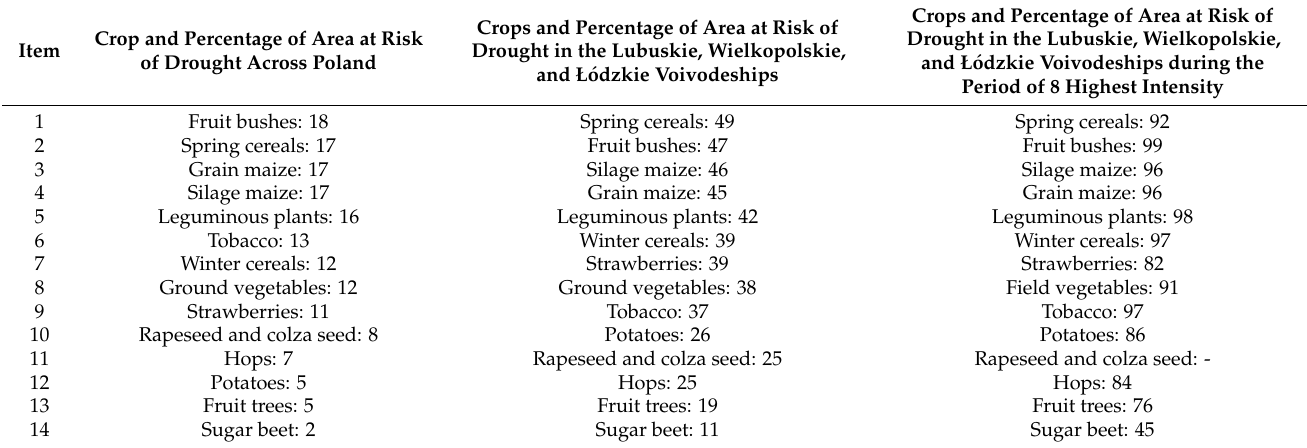
Table 3. Sensitivity of crops to drought. Percentage of drought incidents in 14 consecutive reporting periods and during the period of maximum drought intensity.